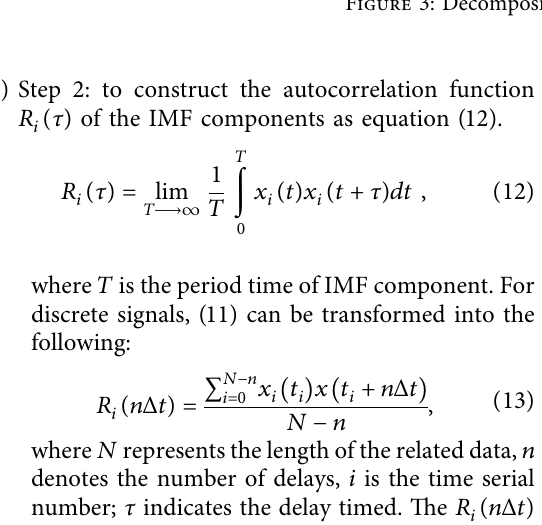
Figure 3: Decomposing process of the